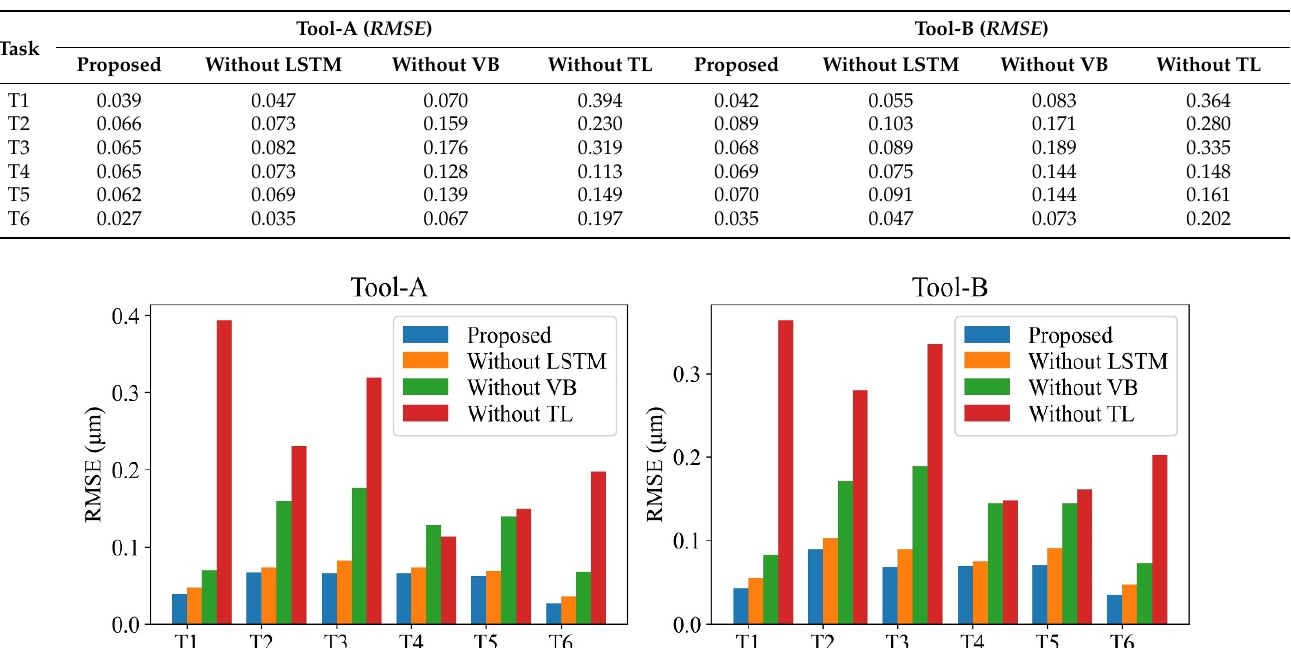
Table 7. Comparison results of different prediction models.